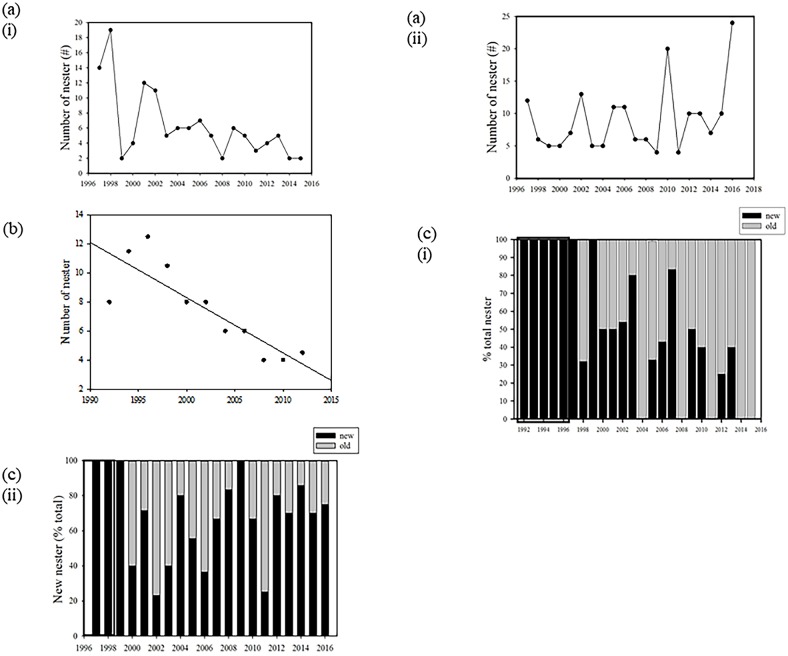
Changes in the nesting population and recruitment rate (proportion of new nesting females) for both the Wan-an Island and Lanyu Island populations.(a) population trend of (i) Wan-an Island rookery (1993–2015) and (ii) Lanyu Island rookery (1997–2015); (b) two-year running mean of Wan-an Island nesting population from 1992 to 2015, with a declining trend observed: number of nesting females = 12.127–0.764(year), n = 11, r = 0.85, p < 0.001; (c) proportion of new nesting females in the nesting population across both islands. The dark frame shows the beginning of the field sampling program completed for this study and represents years without any returns of tagged turtles at (i) Wan-an Island and (ii) Lanyu Island.